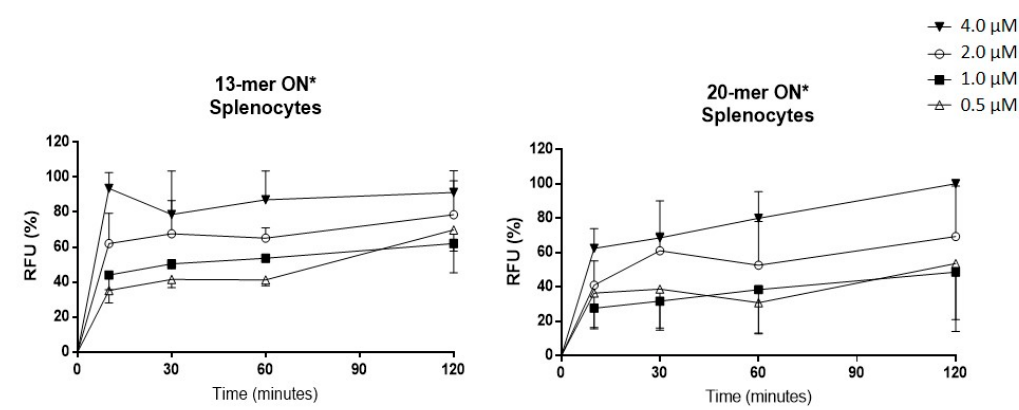
Figure 1. Labeled oligonucleotide (ON) absorption kinetics in splenocytes. Labeled ONs with sizes of 13 or 20 mer were cultured at different times and concentrations in the presence of C57BL6 mouse splenocytes. The fluorescent ONs of either 13 or 20 mer, labeled with Cy5 or FITC, were incubated independently at concentrations of 0.5, 1, 2, and 4 µM at 37 °C at 0, 10, 30, 60, and 120 min. At each time, the splenocytes were analyzed by means of flow cytometry to measure the ON uptake and the % of ONs was calculated with respect to maximal relative fluorescence unit (RFU) values achieved. ON* refers to fluorescent oligonucleotide.